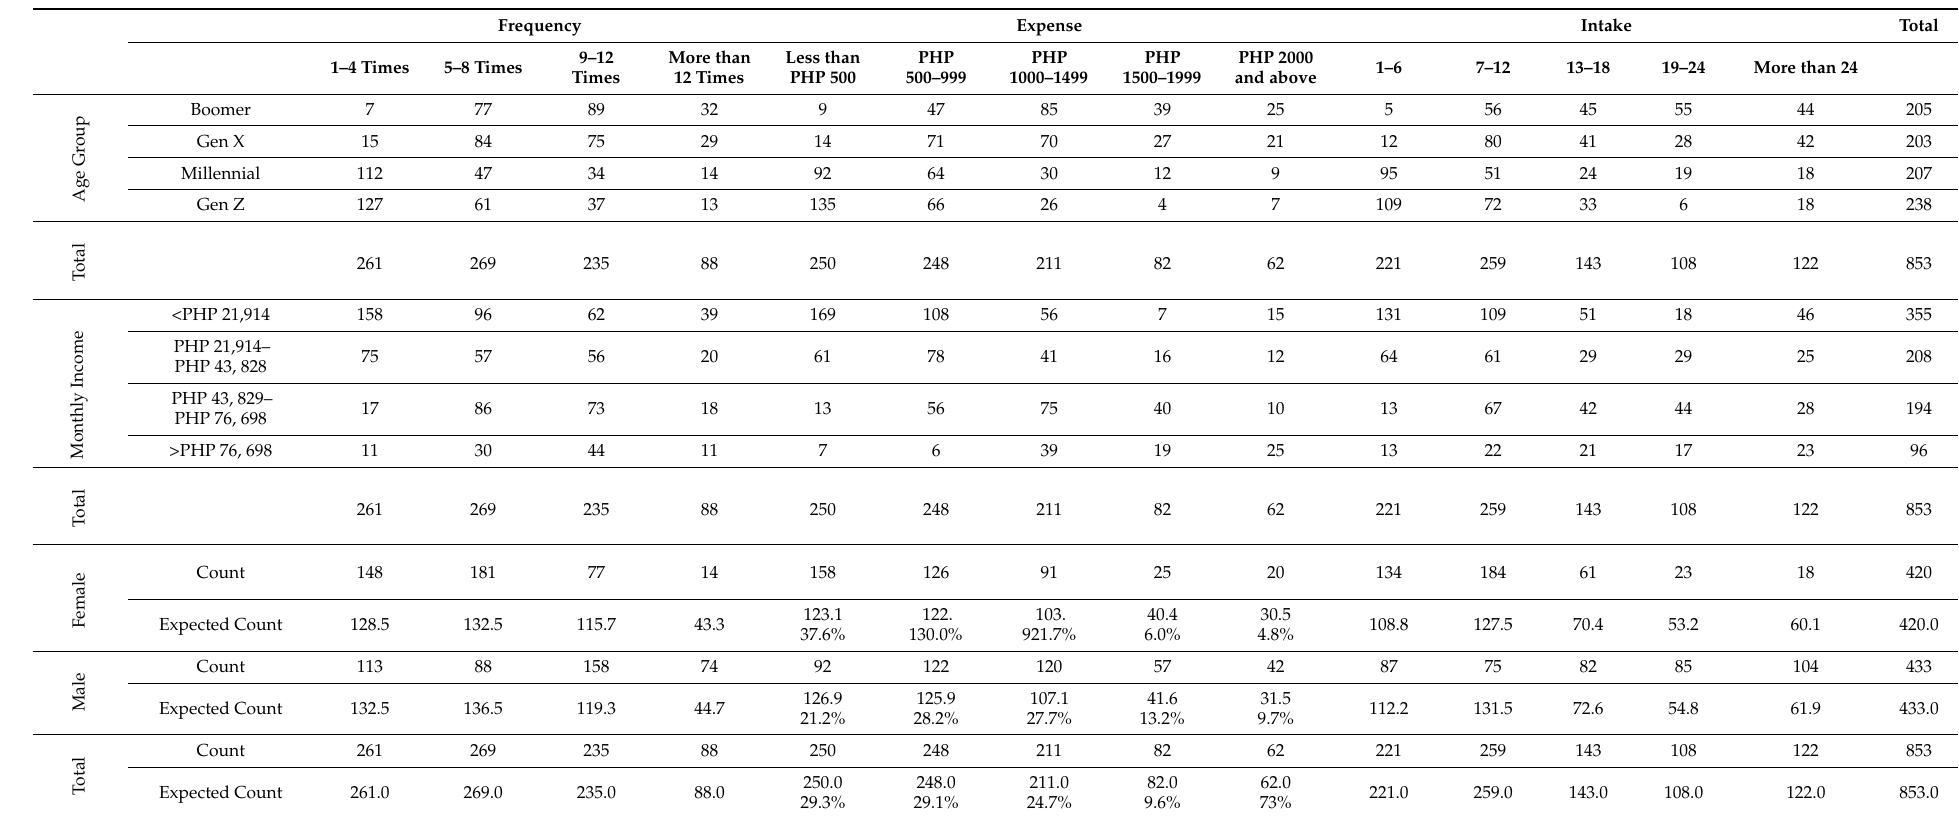
Table A2. Crosstabulations for effect of demographic